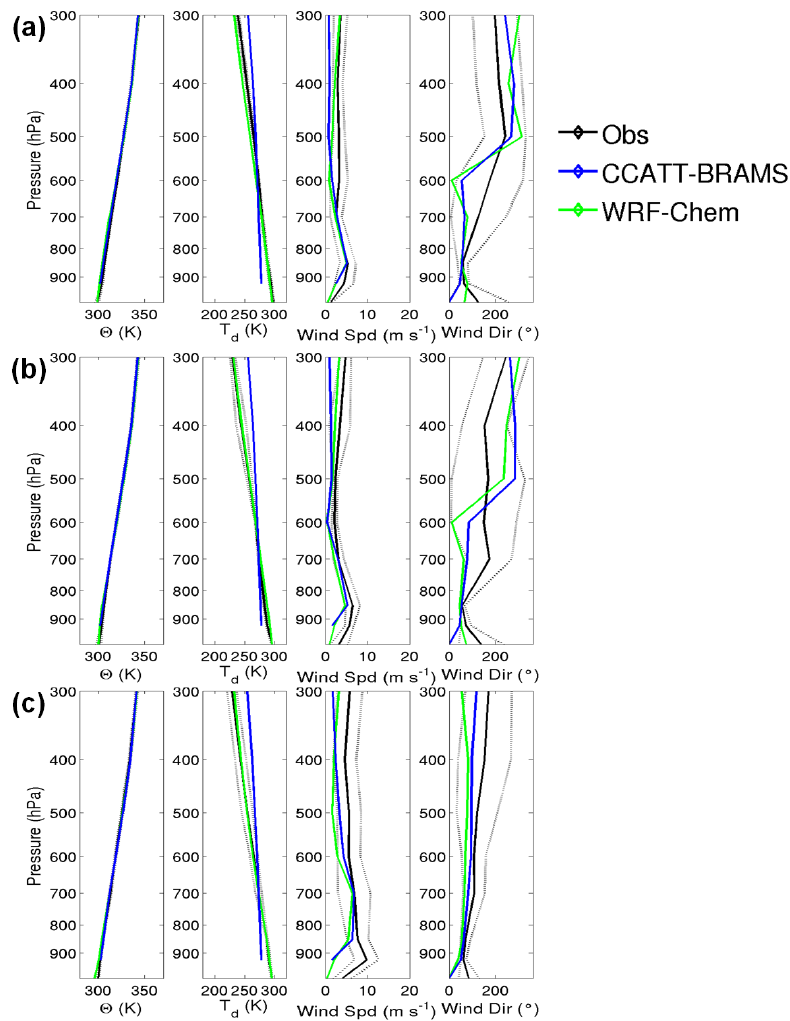
Figure 8. Mean vertical profiles at Manaus from radiosoundings (black, gray line denotes 1 standard deviation), CCATT-BRAMS (blue) and WRF-Chem (green) for October–November 2008 at (a) 00:00, (b) 12:00, and (c)